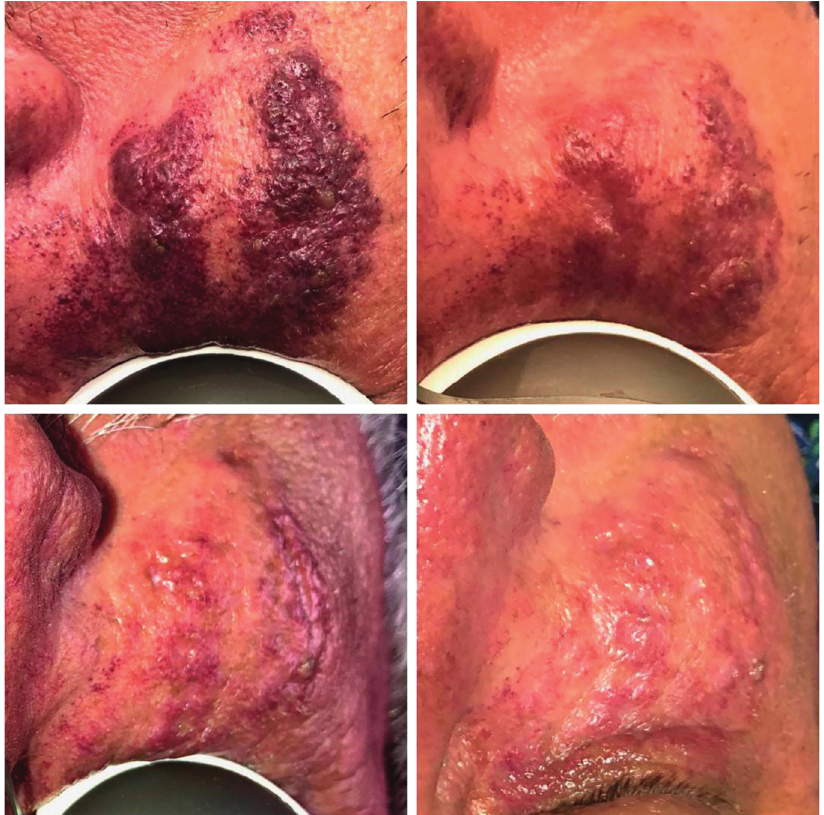
Figure 1: Port-wine stain after 3 Nd:YAG laser